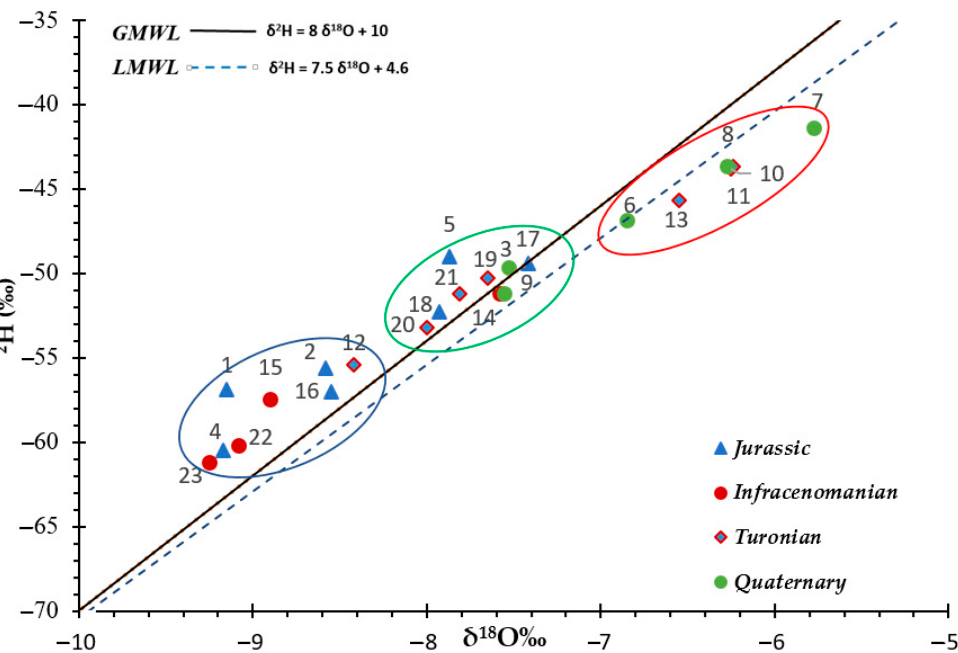
Figure 8. δ 18 O‰ vs. δ 2 H‰ plot of groundwater samples from the study area compared to GMWL [30] and LMWL [31].